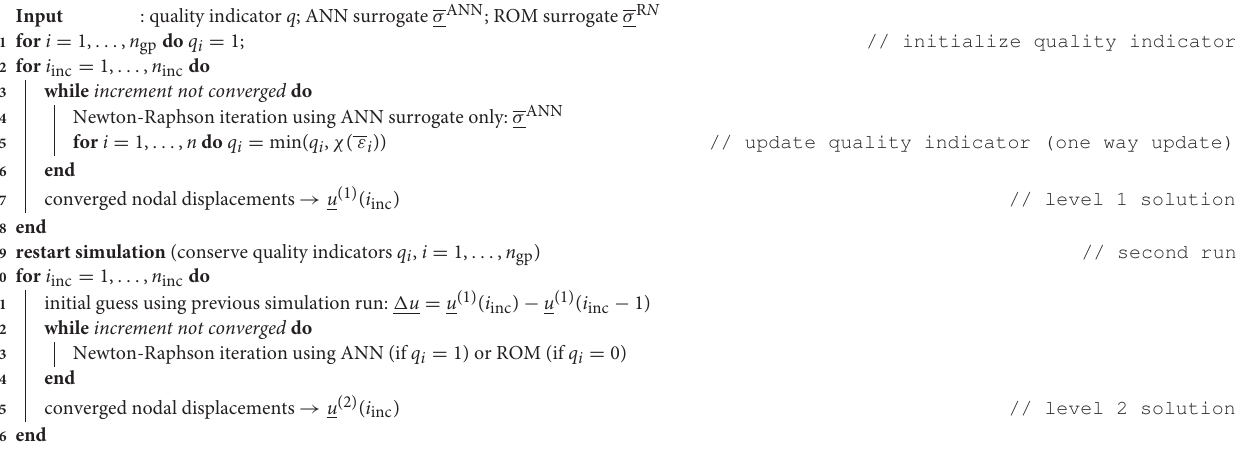
Algorithm 1: Staggered hybrid ANN/ROM twoscale simulation algorithm.